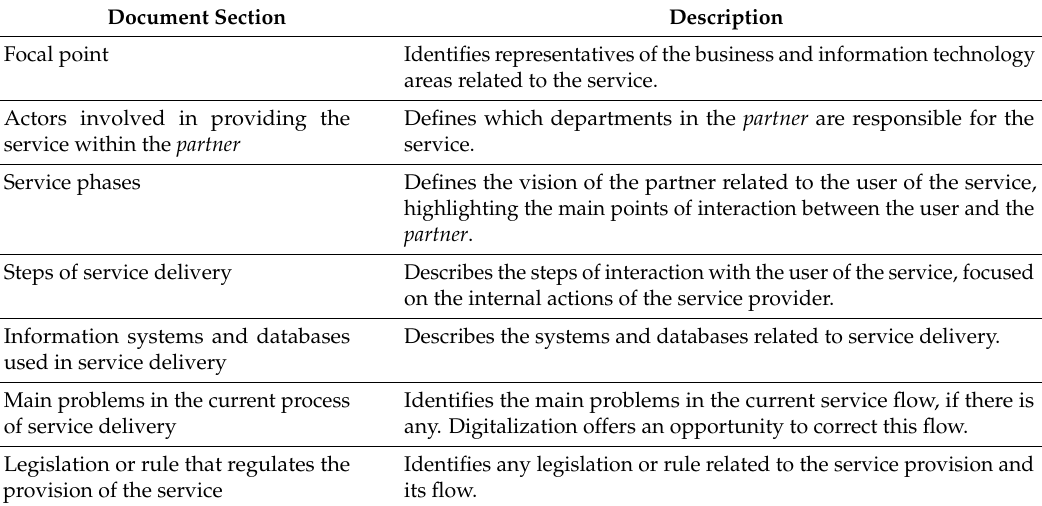
Table 2. Diagnostic plan